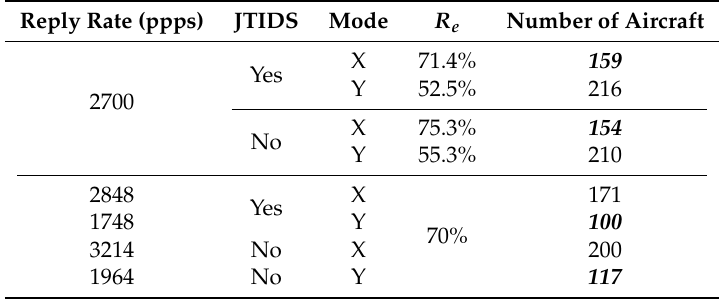
Table 2. DME Capacity under the limitations of reply rate and reply